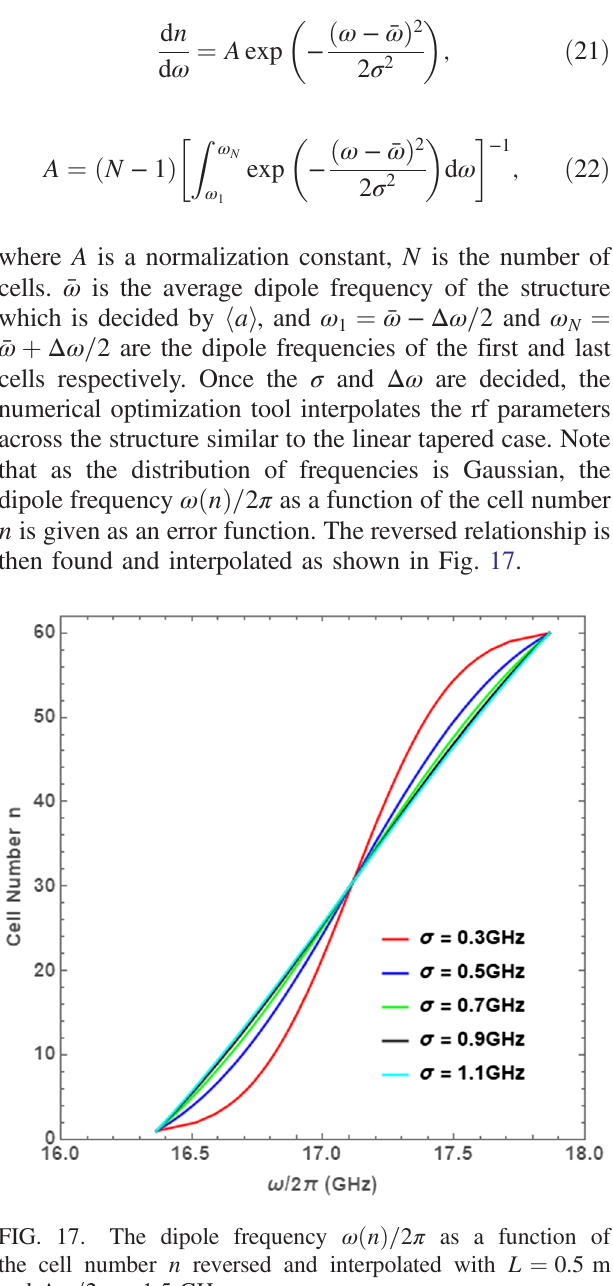
FIG. 17. The dipole frequency ω ð n Þ = 2 π as a function of the cell number n reversed and interpolated with L ¼ 0 . 5 m and Δ ω = 2 π ¼ 1 . 5 GHz.